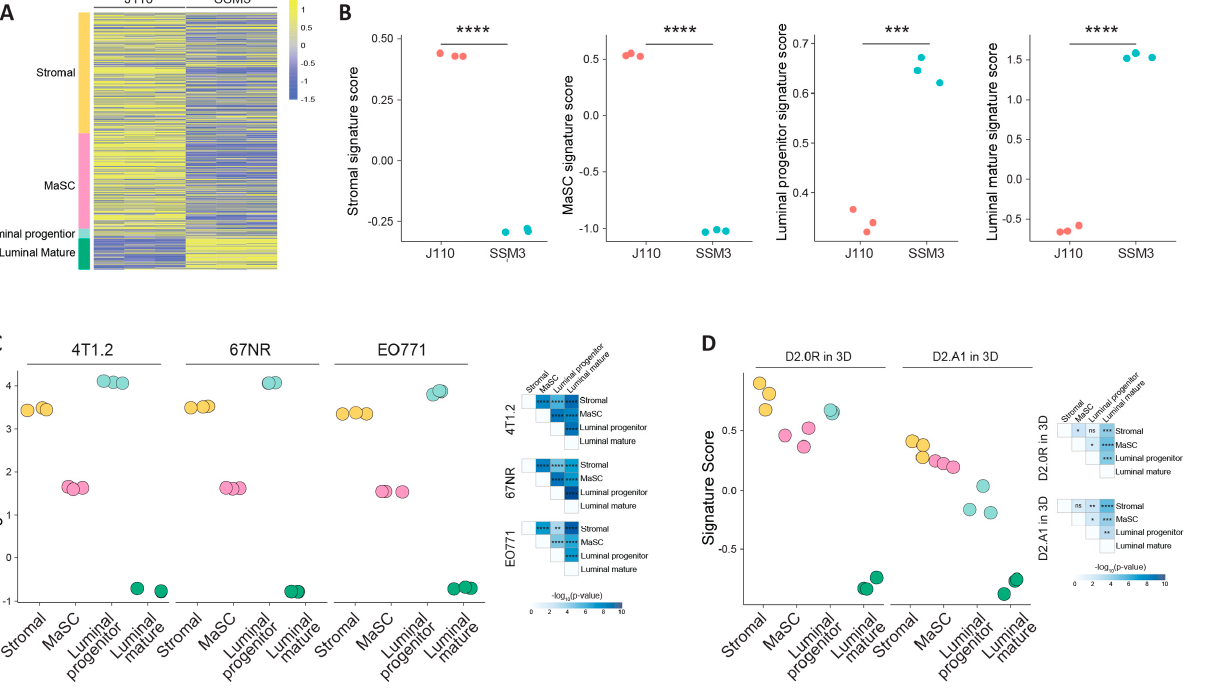
Figure 6. Molecular assessment of syngeneic cell lines and expression of cell-specific gene signatures. ( A ) Heatmap of genes in the MaSC, luminal progenitor and luminal mature gene signatures [16] and a stromal gene signature [15] ( B – D ) Gene signature scores calculated using MaSC, luminal progenitor and luminal mature genes [16] and stromal gene signature [15] in ( B ) J110 and SSM3 cells, ( C ) 4T1.2, 67NR, EO771 cells (GSE42272) and ( D ) D2A1 and D2.0R cells (GSE172882). Differences in the mean signature scores were calculated using student’s t -test. **** ≤ p 0.0001, *** ≤ p 0.001,